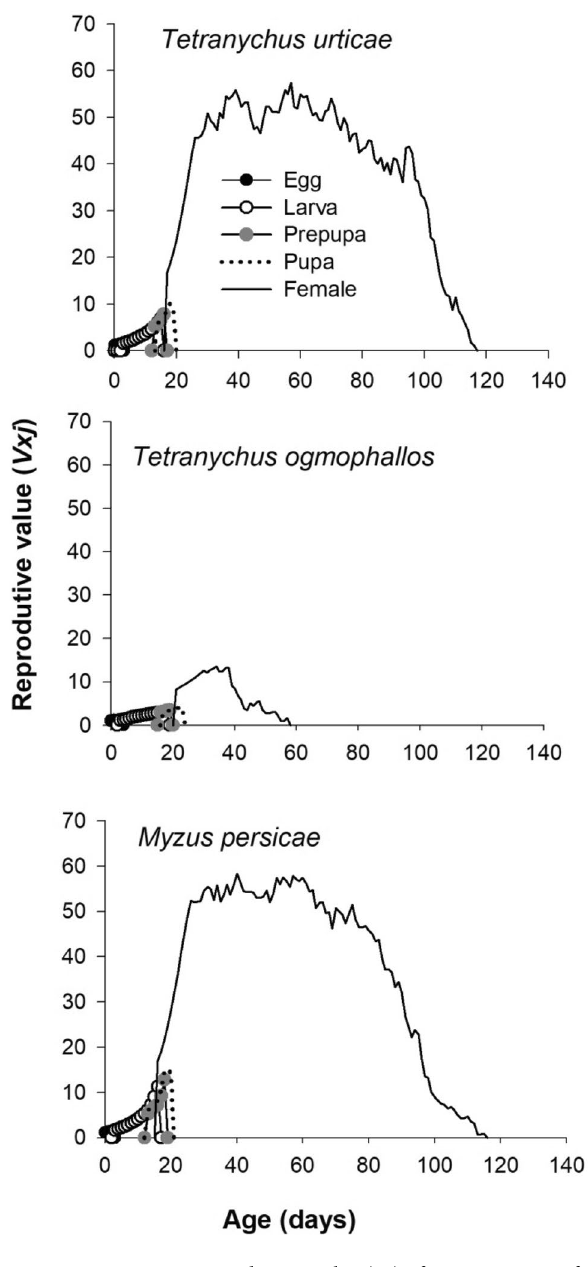
Figure 5. Age-stage reproductive value (v xj ) of Eriopis connexa fed on Tetranychus urticae , Tetranychus ogmophallos , or Myzus persicae